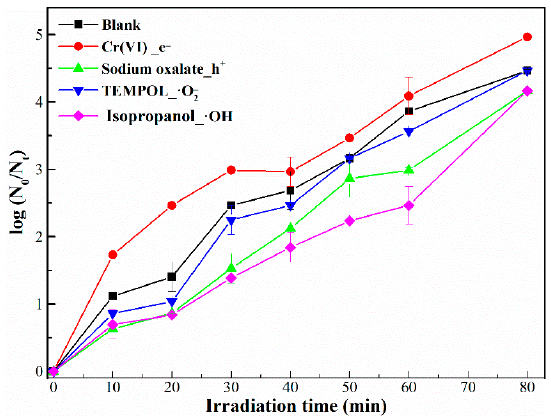
Figure 10. Effect of different active radical scavengers on photocatalytic inactivation of bacteriophage f2 by AgCN composite photocatalysts. f2 by AgCN composite